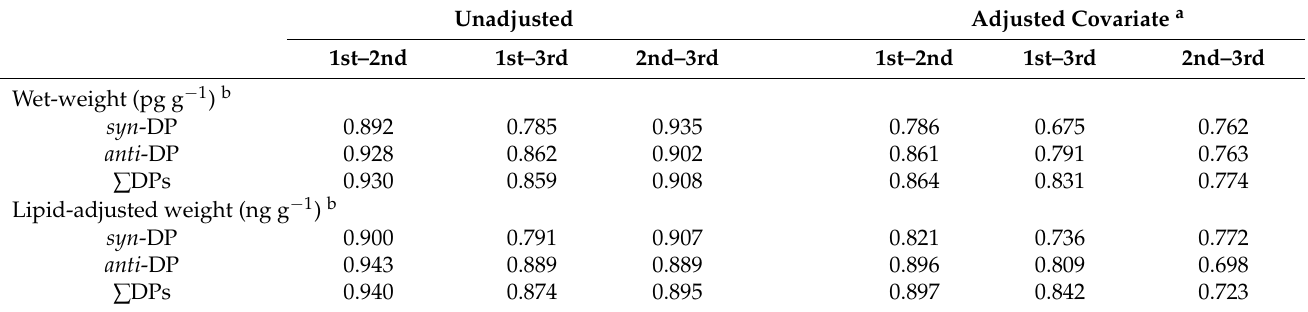
Table 2. Unadjusted/adjusted inter-period correlation of log-transformed trimester-related DP levels. Unadjusted Adjusted Covariate a